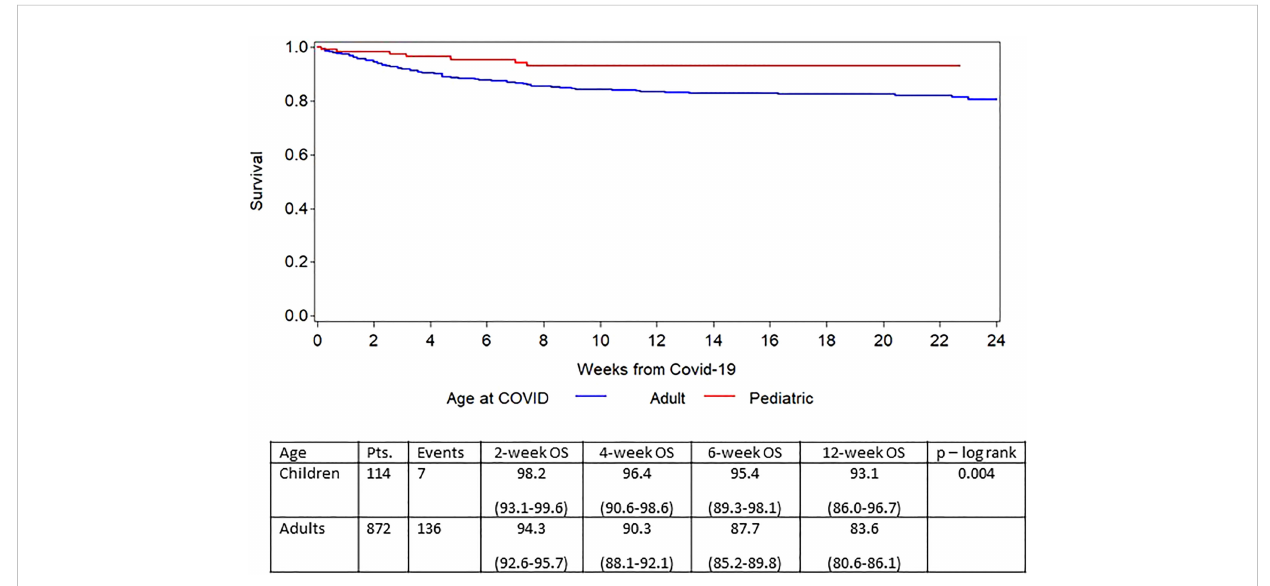
FIGURE 2 Survival after diagnosis of COVID-19 in adults and